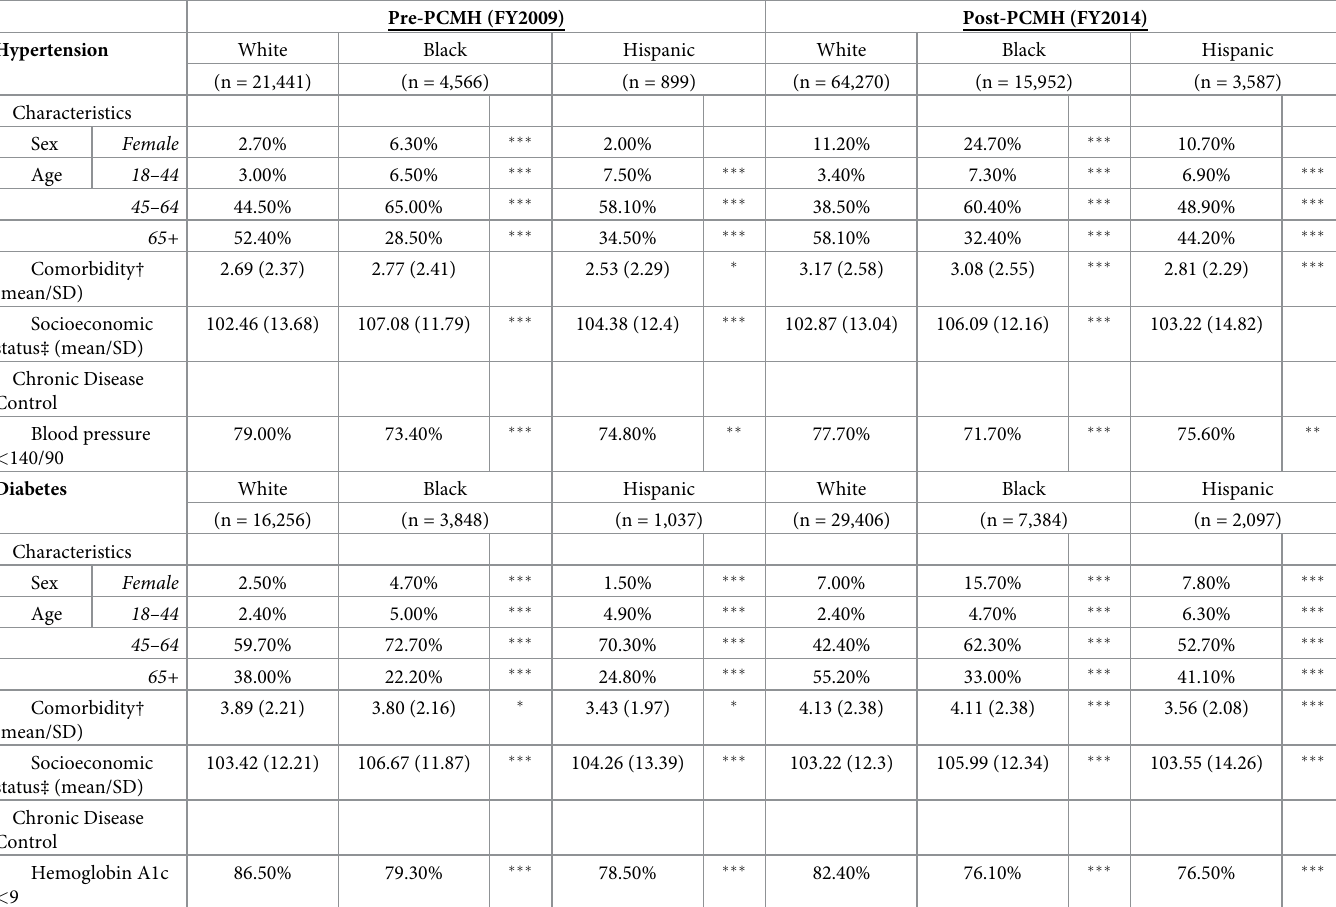
Table 1. Patient characteristics by racial-ethnic group before and after VHA patient-centered medical home